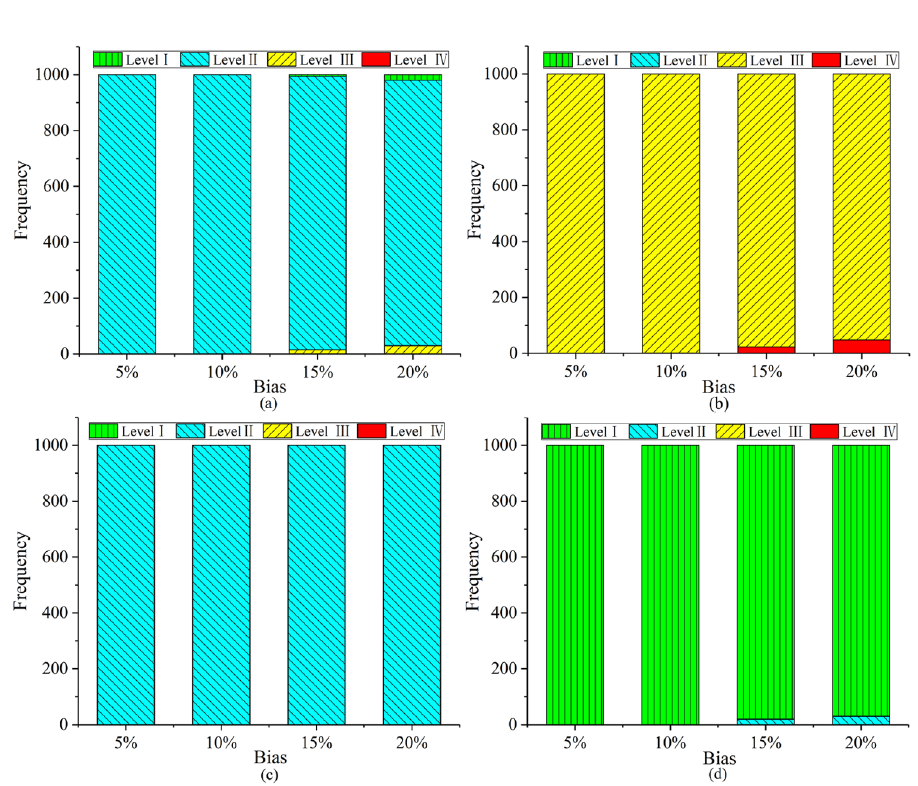
Figure 8. Tunnel collapse risk assessment results after 1000 iterations under different deviation levels at four section: ( a ) No.1; ( b ) No.2; ( c ) No.3; ( d )